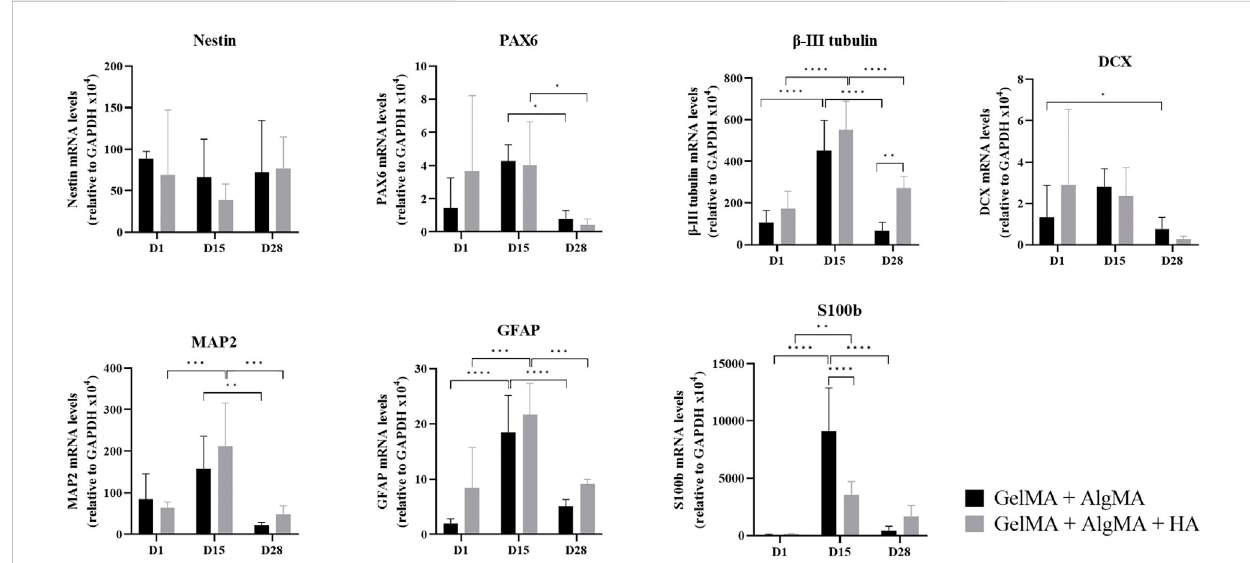
FIGURE 6 Quantitative expression of neural nestin, PAX6, β -III tubulin, MAP2, GFAP, S100b , and DCX genes relative to GAPDH in C17.2 cells in the two formulations on days 1, 15, and 28 of culture. Data are presented as mean ± standard deviation. Statistical signi fi cance was calculated using a two-way variance analysis (ANOVA) with Turkey ’ s and Sídák ’ s post hoc multiple comparisons test considering * p < 0.05; ** p < 0.01; *** p < 0.001; **** p <